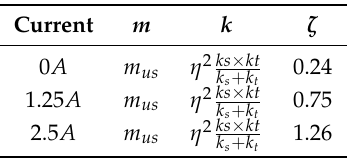
Table 9. Current to damping ratio